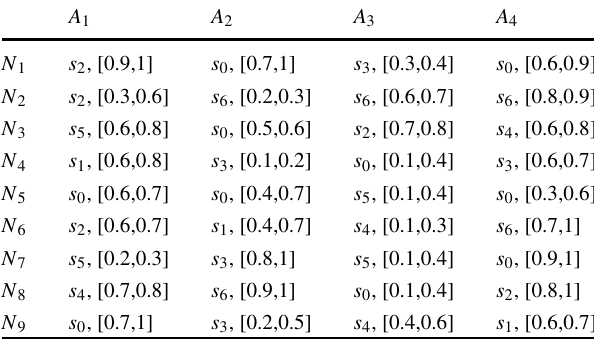
Table 2 The decision matrix with confidence interval values according to the first voting node